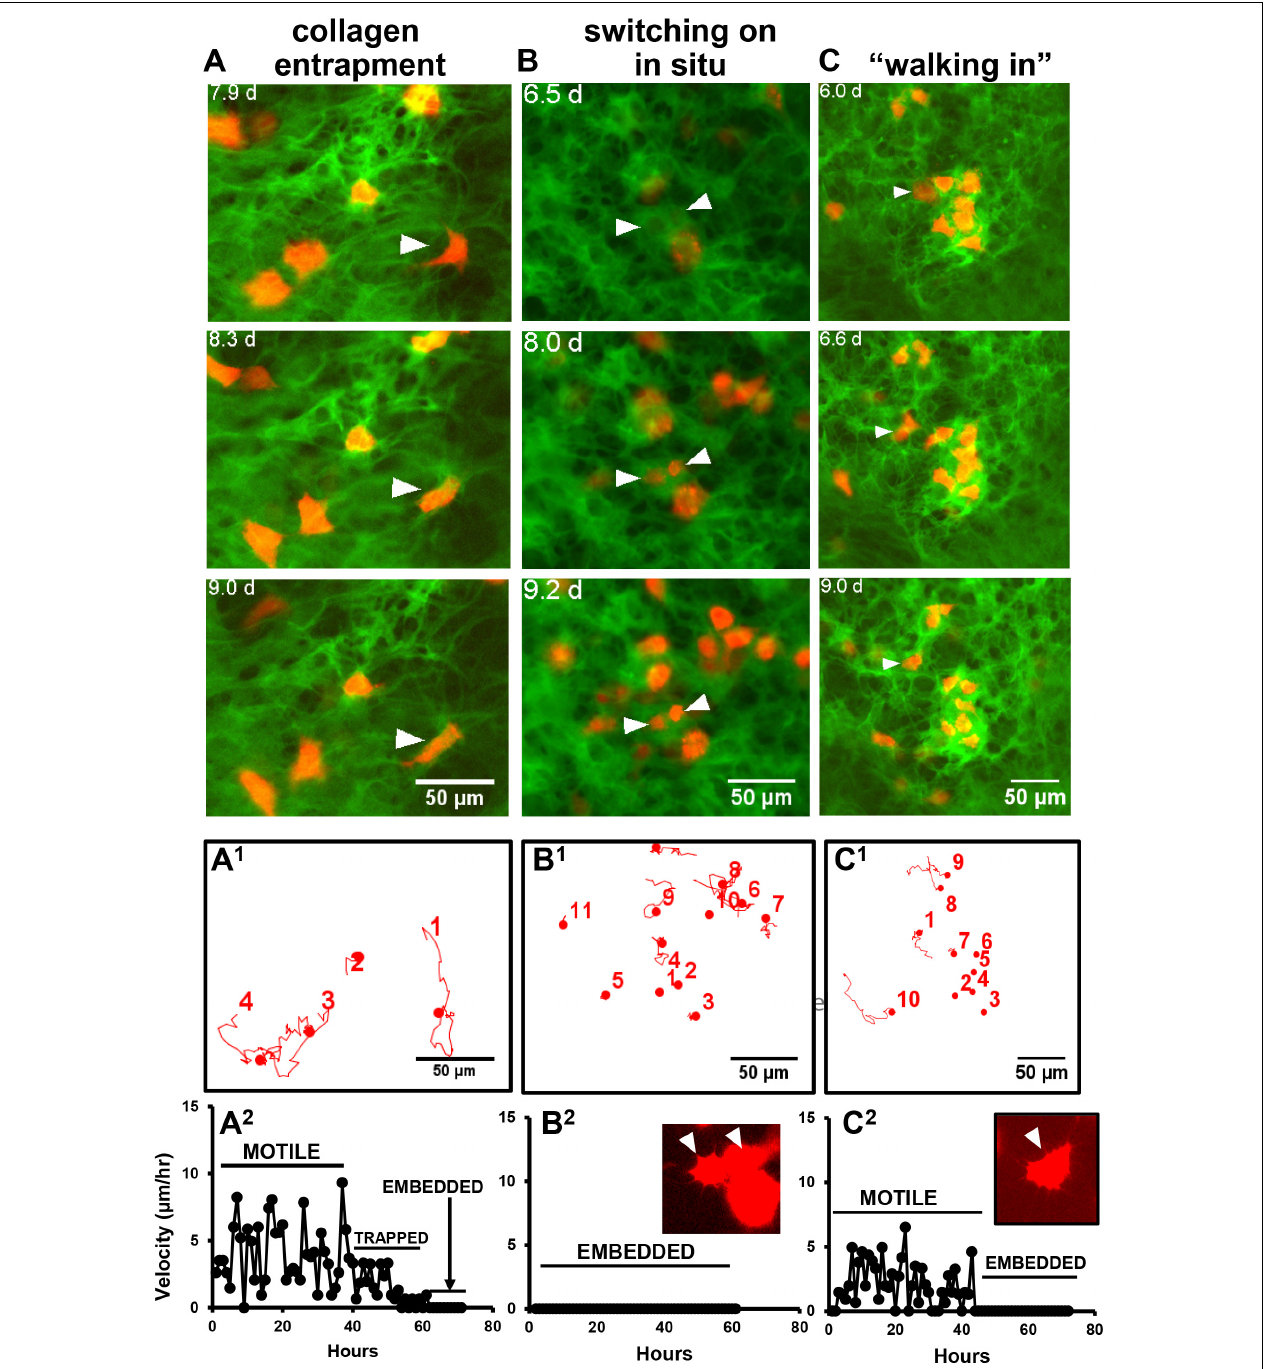
FIGURE 6 | Multiple mechanisms for osteocyte embedding. (A–C) Still frames from timelapse movies that illustrate the different mechanisms of embedding of tdTomato-positive cells in osteogenic calvarial cell cultures from GFP-collagen/Dmp1-Cre/tdTomato transgenic mice. (A) shows a tdTomato-positive cell (arrowhead) becoming embedded via collagen entrapment. This cell initially shows motile activity until around 8 days, when a network of collagen fibers is assembled around the cell, thereby immobilizing it. This is best visualized dynamically by viewing Supplementary Movie 11 ; (B) shows two cells (arrowheads) that switch on tdTomato expression in situ while already located within a lacuna. This is best visualized dynamically by viewing Supplementary Movie 12 ; (C) shows a tdTomato-positive cell (arrowhead) that shows motile activity and “walks into” an already formed lacuna in the collagen matrix. The contours of the cell then conform to the contours of the lacuna. This is best visualized dynamically by viewing Supplementary Movie 13 . (A 1 –C 1 ) Show motion trajectory plots for the cells in movies (A–C) , respectively. (A 2 –C 2 ) Show the motility profiles for the featured cells in (A–C) , respectively, that exemplify the different embedding behaviors. The inset images show that the morphology of the embedded cells in movies (B,C) at the end of the movie resemble the dendritic morphology of osteocytes. In all panels, bar = 50 µ m.